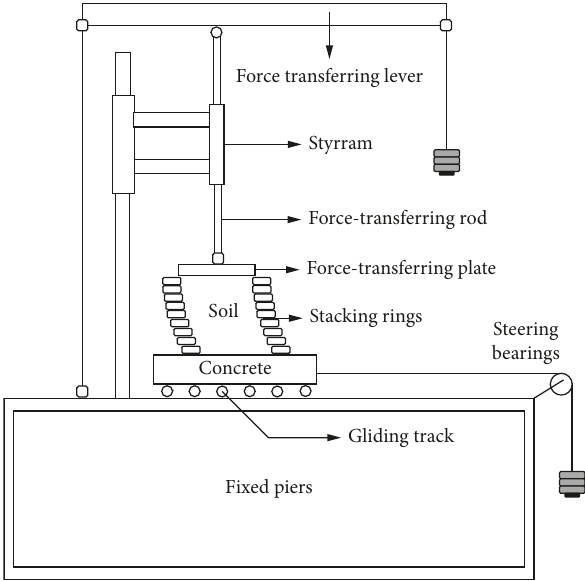
Figure 4: Contact surface shear test schematic